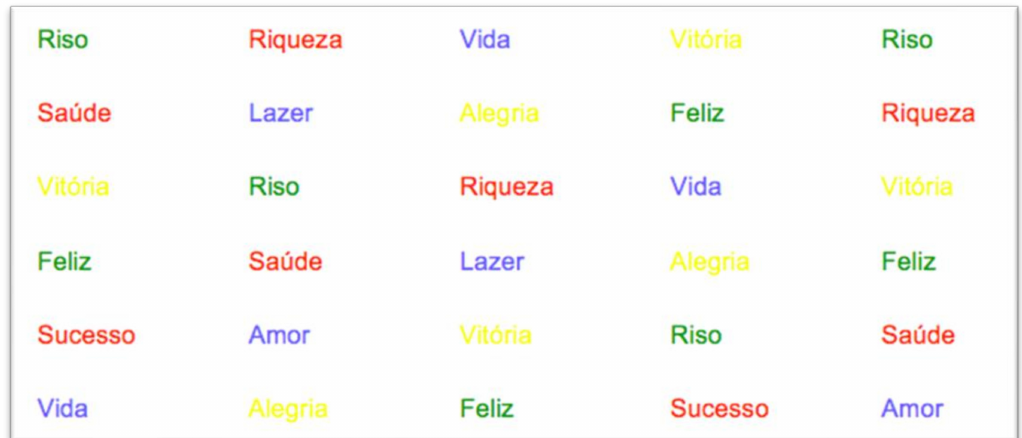
Figure 2. The ten positive words.